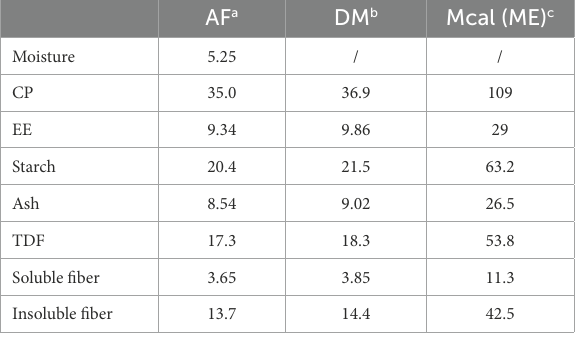
TABLE 1 Nutrient composition of the experimental diet used in the study (VetSolution Obesity Canine, Monge & C. S.p.a., Monasterolo di Savigliano,